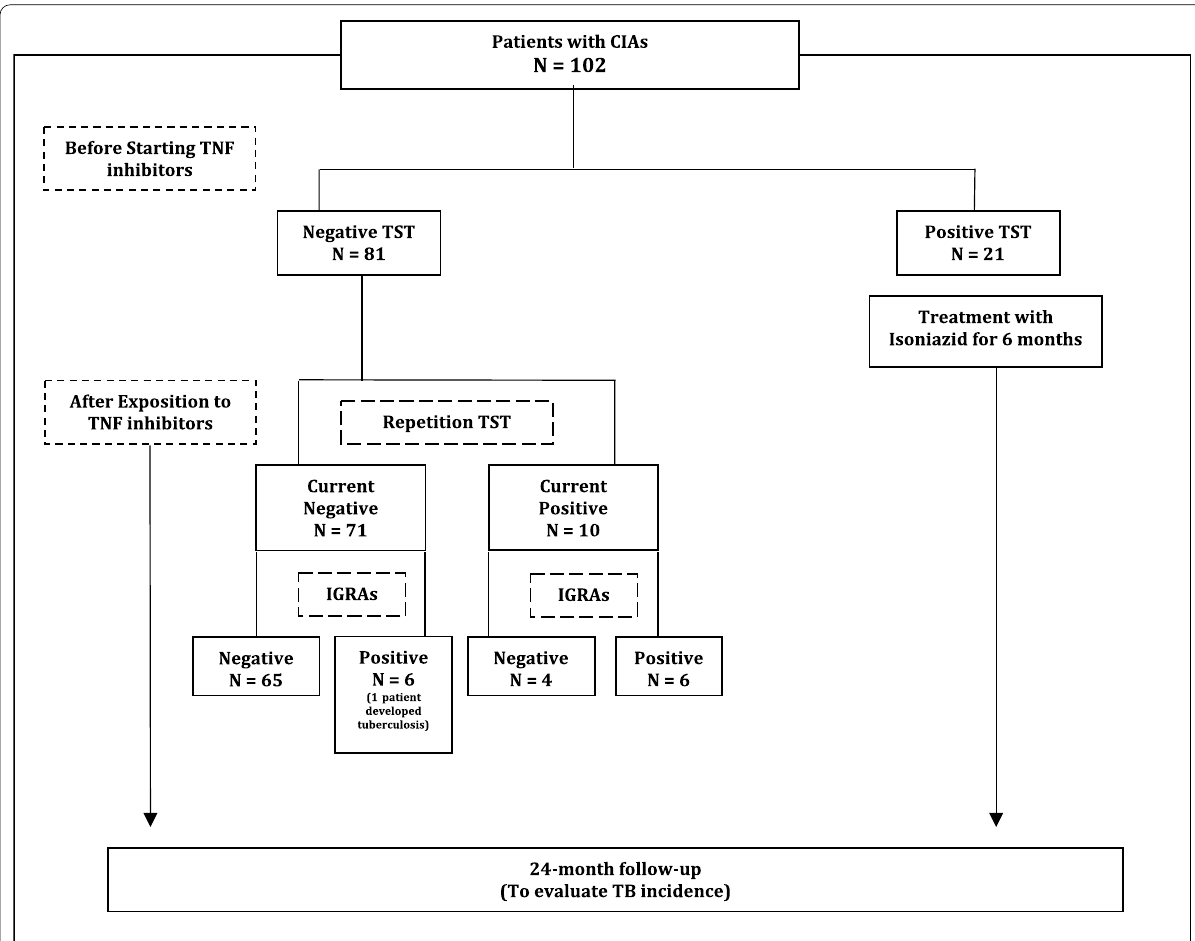
Fig. 1 Flowchart of TST and IGRAs after TNFα inhibitors introduction during a 24‑Month follow‑up, including a cross‑sectional and other prospective phase